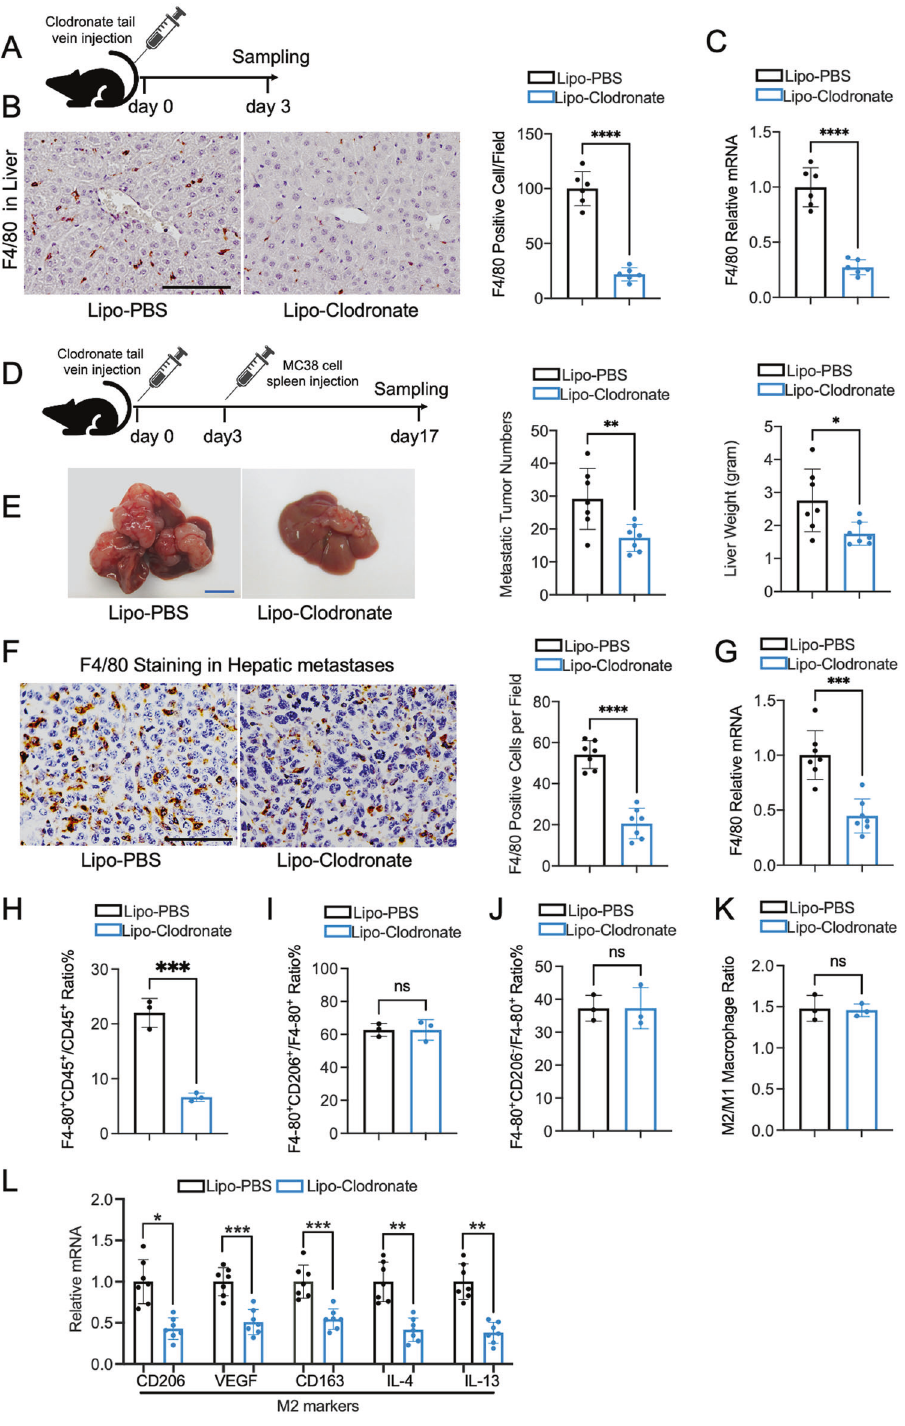
Fig. 2 Depletion of macrophage in the liver attenuated colorectal cancer liver metastasis in the mouse model. A Schematic protocol of macrophage depletion in the mouse liver using Lipo-Clodronate tail vein injection. B F4/80 Immunohistochemistry staining and quanti fi cation of Lipo-PBS and Lipo-Clodronate treated mice liver. n = 6 each group; Scale bar, 100 μ m; fi ve fi elds were counted per sample. C F4/80 mRNA expression in mouse liver. D Schematic diagram of colorectal cancer liver metastasis model using liver-macrophage depletion mice. E Visible hepatic metastatic tumor nodules and liver weight in mice model. n = 7 per group; Scale bar, 10 mm. F Representative images and quanti fi cation of F4/80 staining in the metastatic tumor area. n = 6 each group; Scale bar, 100 μ m; fi ve fi elds were counted per sample. G Relative F4/80 mRNA expression in the tumor. H Flow cytometry analysis of F4-80 + CD45 + /CD45 + cell ratio in hepatic metastases of mouse model. I Flow cytometry analysis of F4-80 + CD206 + / F4-80 + cell ratio in hepatic metastases of mouse model. J Flow cytometry analysis of F4- 80 + CD206 - / F4-80 + cell ratio in hepatic metastases of mouse model. K Quanti fi cation of F4-80 + CD206 + / F4-80 + CD206 - cell ratio in hepatic metastases of mouse model. L M2 macrophage markers(CD206, VEGF, CD163, IL-4, IL-13) mRNA expression level in the tumor. Data are means ± SEM. * P < 0.05, ** P < 0.01, *** P < 0.005, **** P <